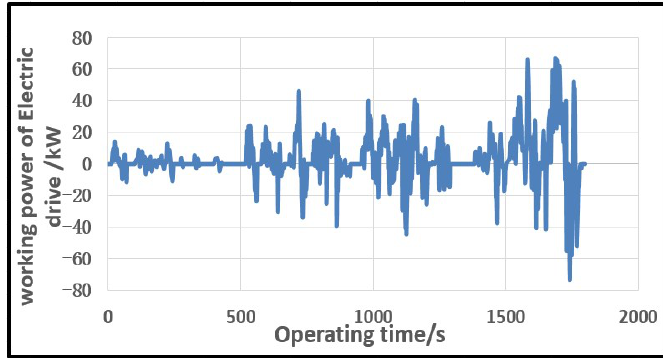
Figure 4. Motor power versus time.